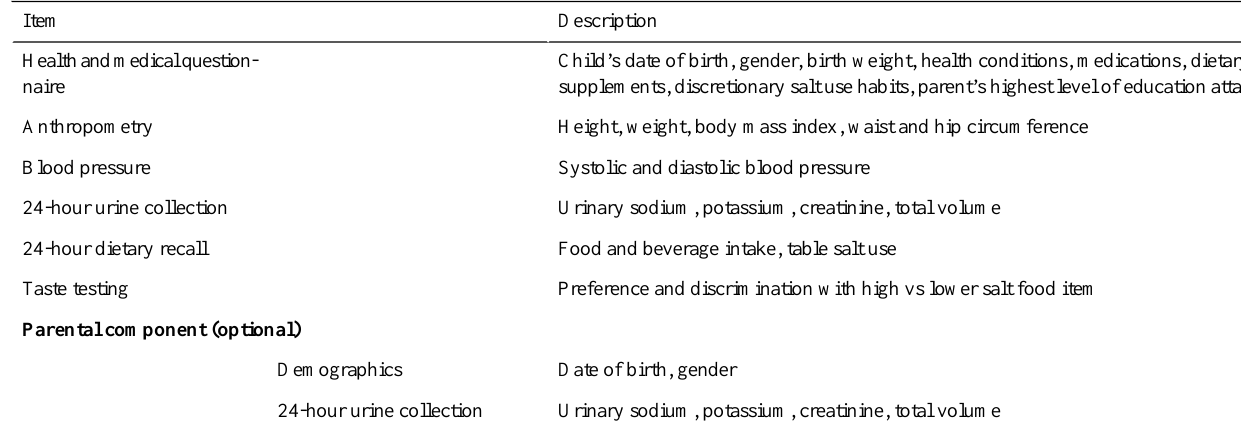
Table 1. Overview of data